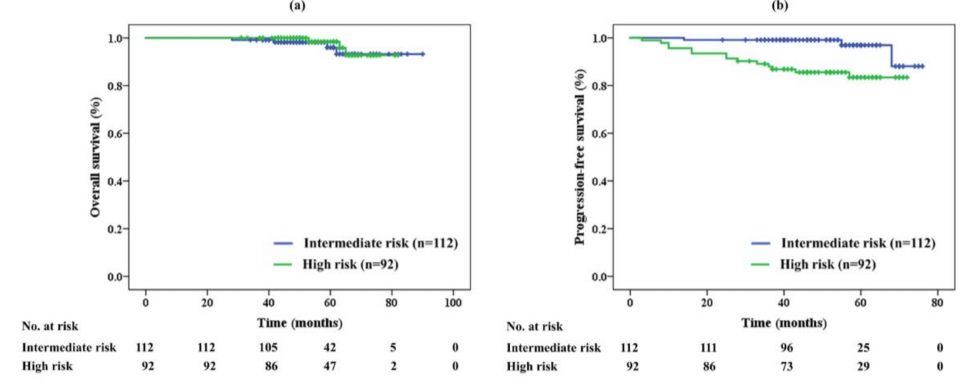
Figure 1. ( a ) Overall survival and ( b ) progression-free survival of proton beam therapy alone in each risk group